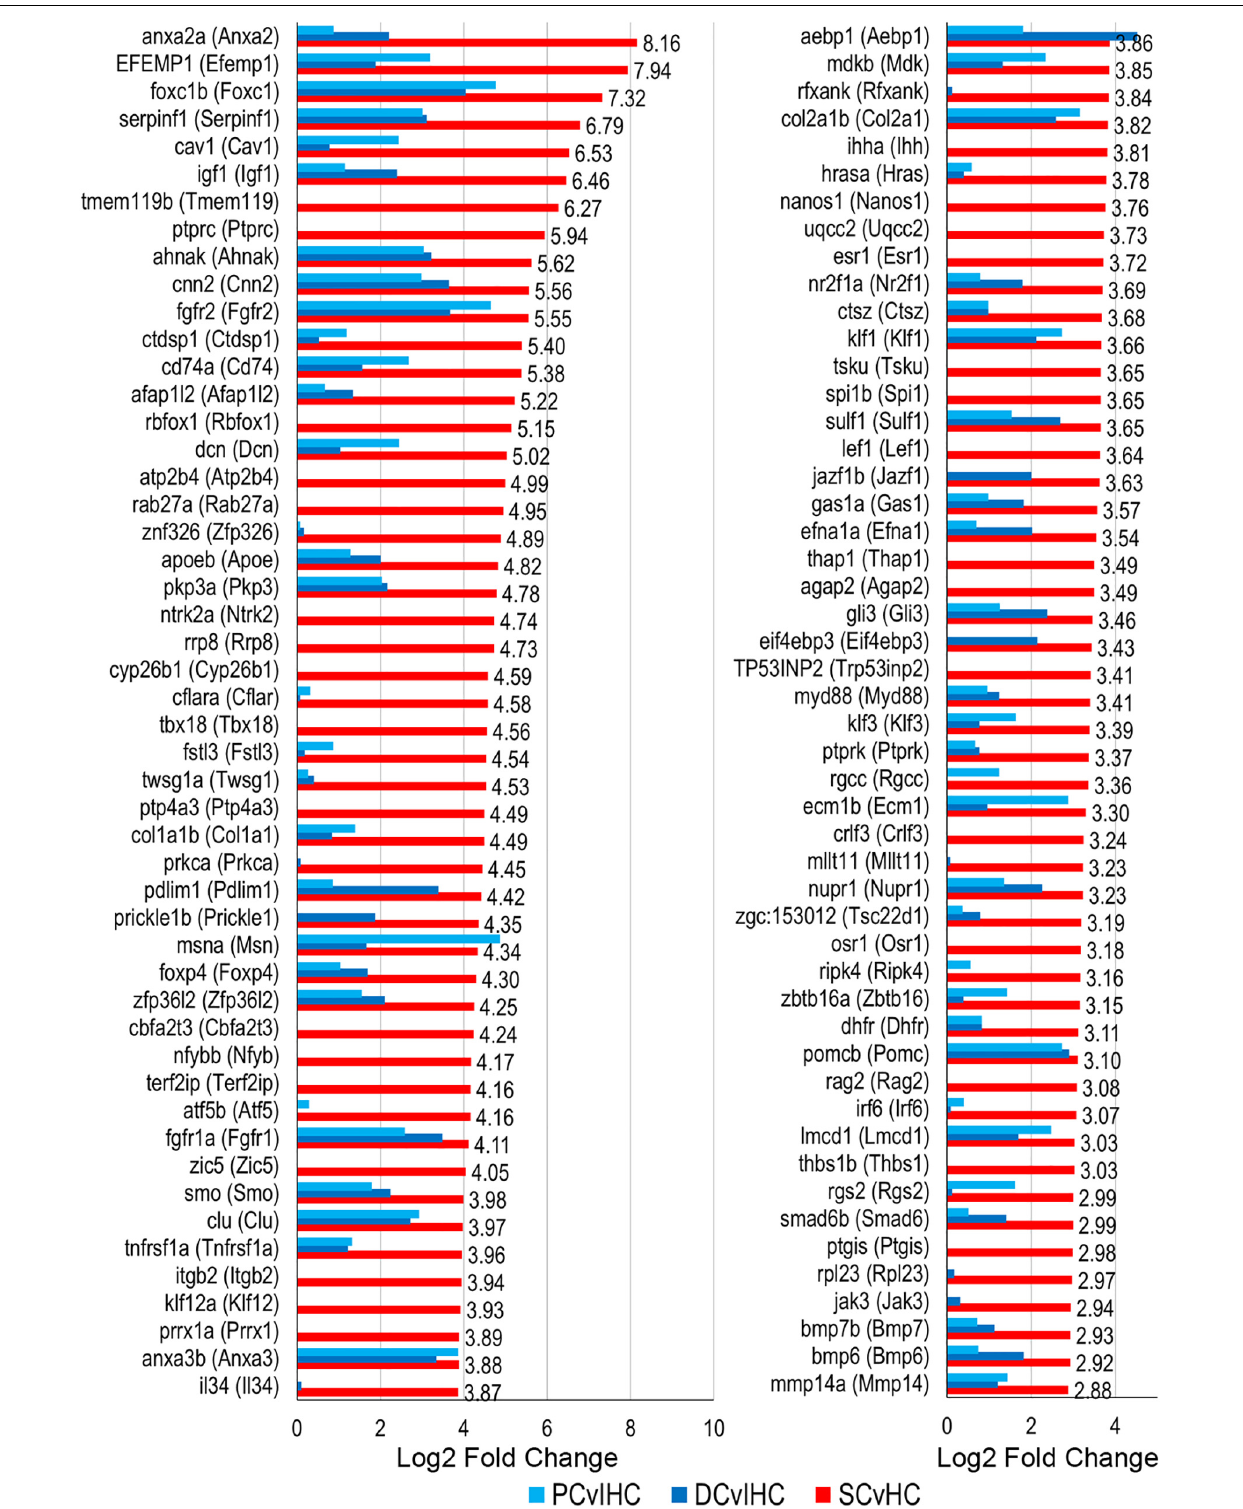
Frontiers in Neuroscience |